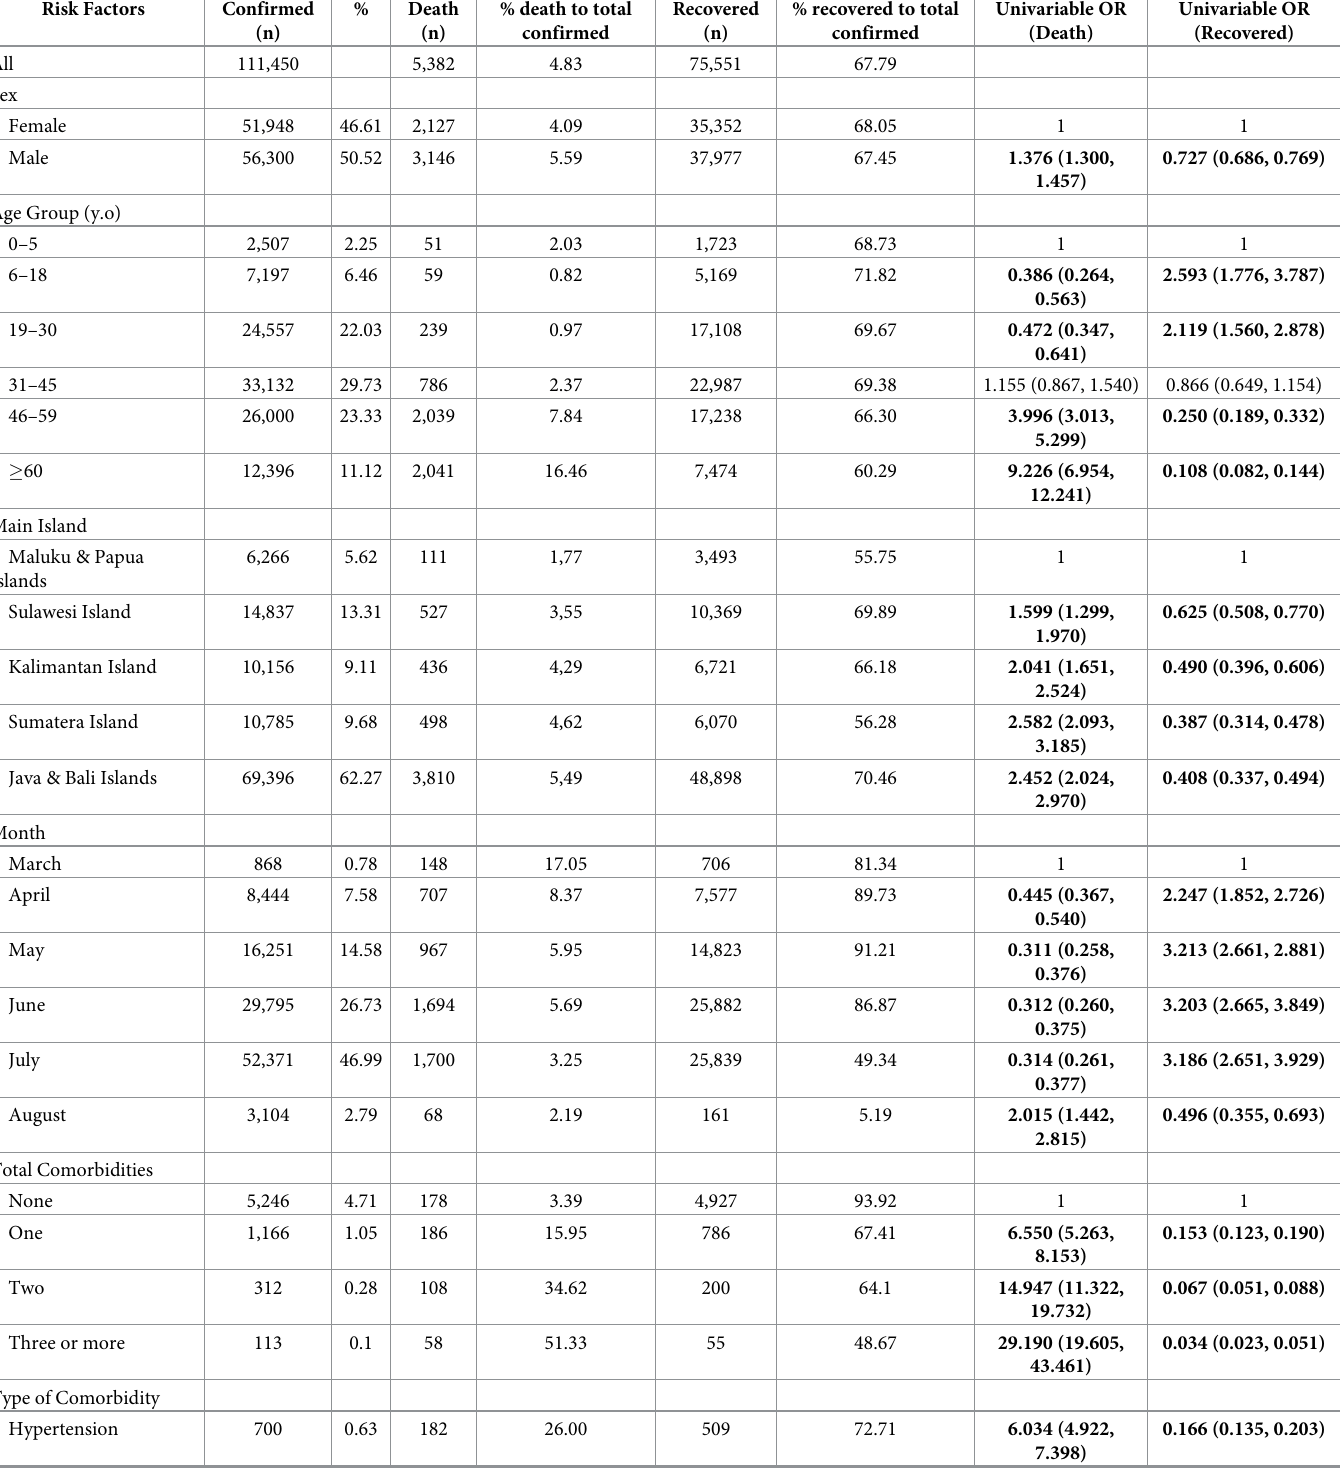
Table 2. Risk factors (according to sex, age group and main island) for mortality of COVID-19 in Indonesia from March 2 nd –August 2 nd 2020. Risk